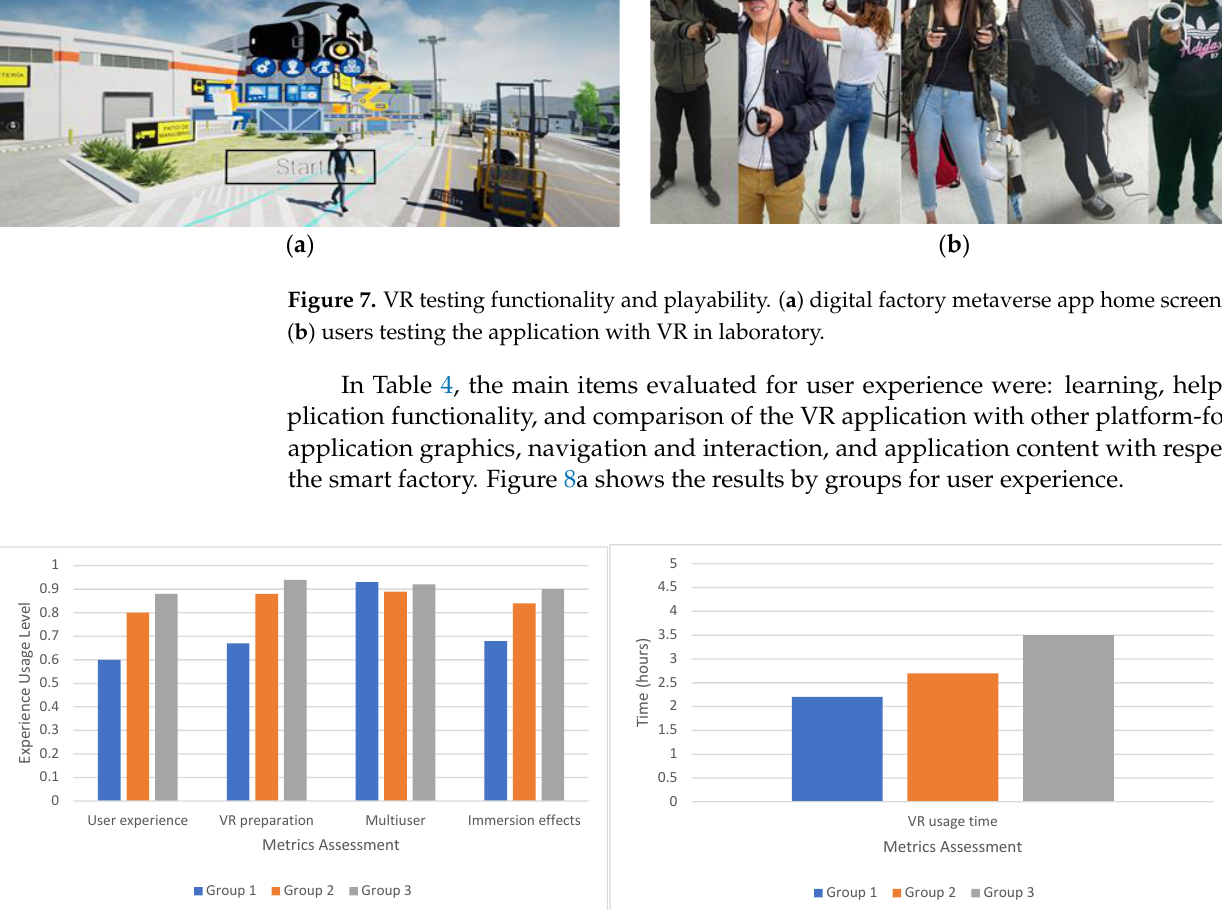
Table 5. Main metrics evaluation results.